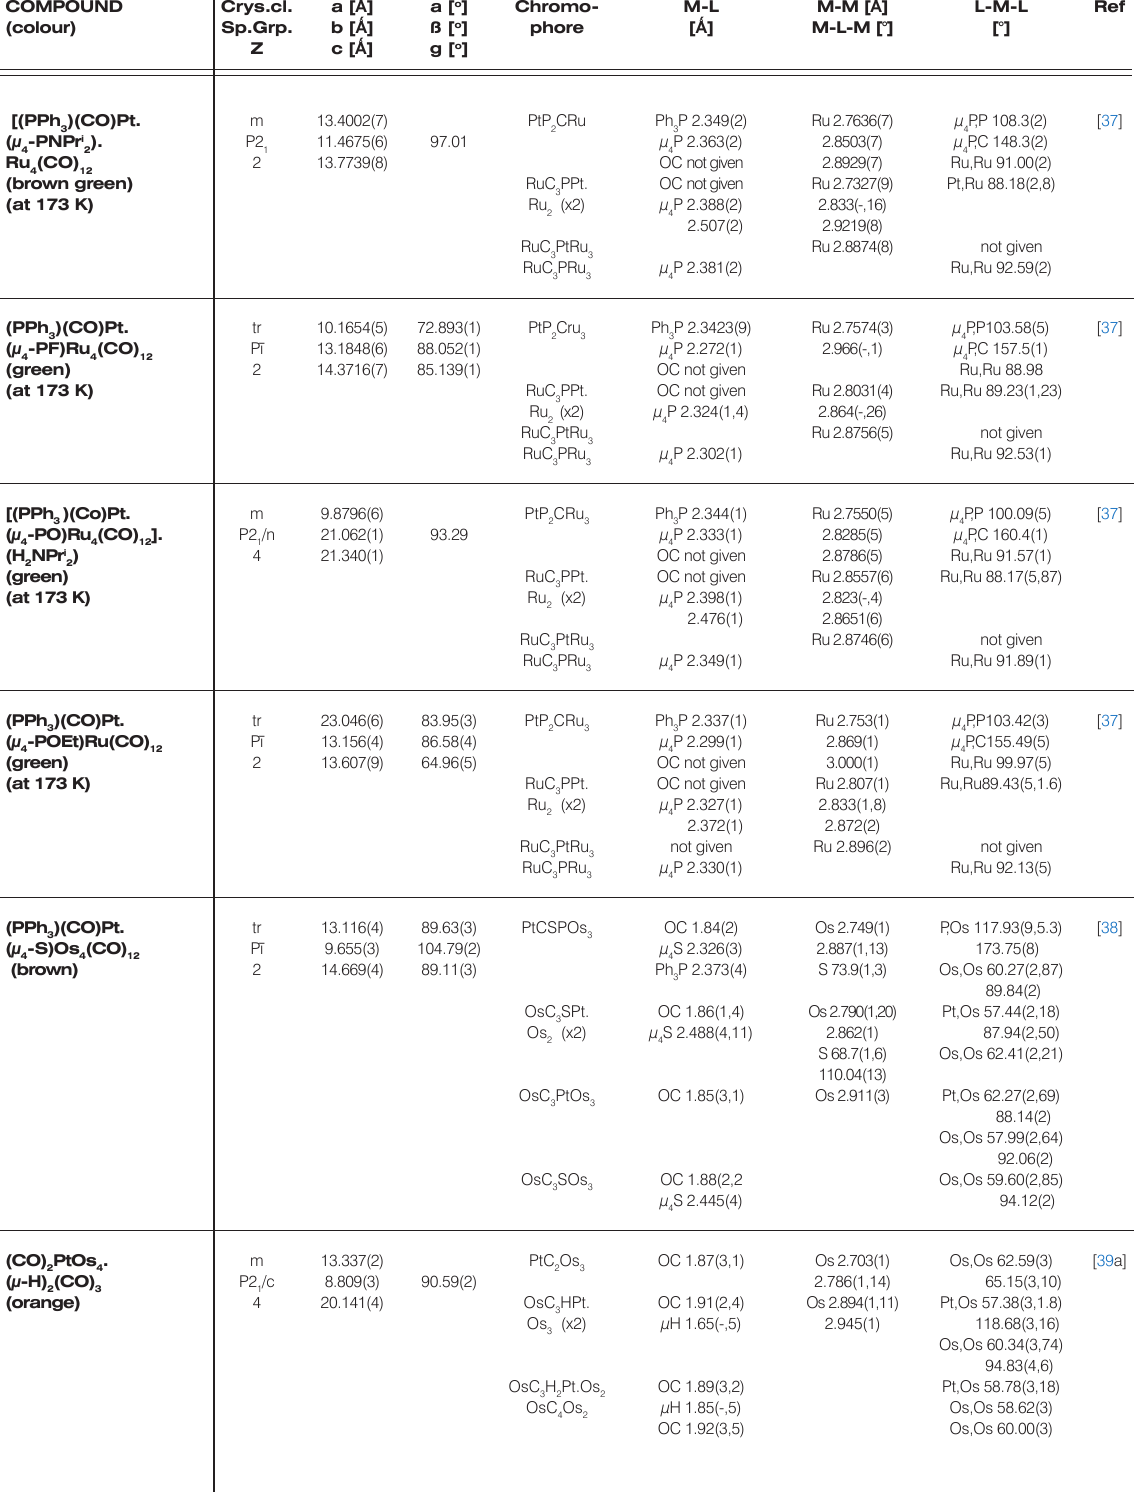
, Pt MM’, Pt M M’, Pt M M ’ and PtM 4 3 2 2 2 2 2